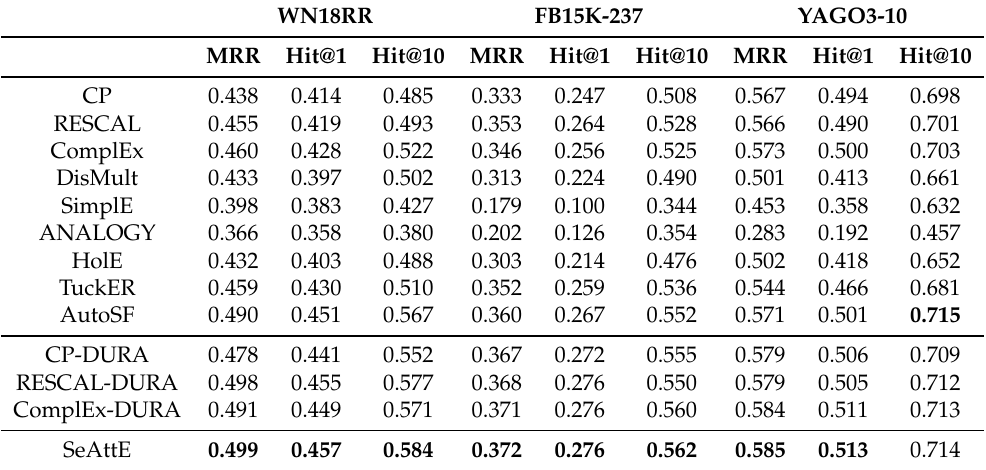
Table 4. This is the results of tensor decomposition models on WN18RR, FB15K-237 and YAGO3-10. The best results of each metric for each dataset are marked in